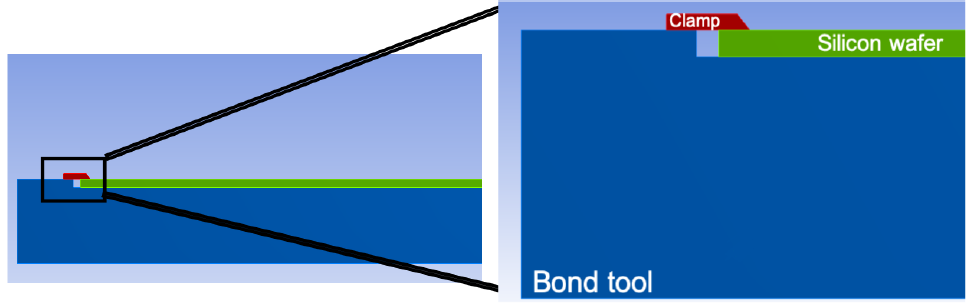
Figure 3. Lateral view and zoom of the wafer system gripped with tool